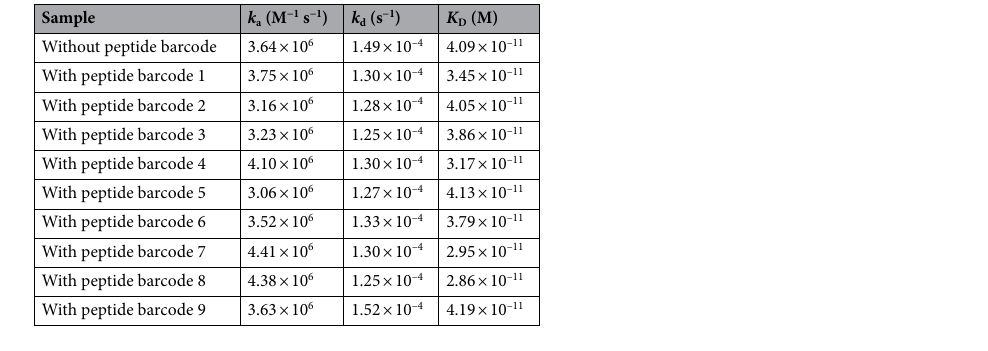
Table 1. Binding kinetics of anti-green fluorescent protein wild-type nanobody fused with peptide barcodes with various physicochemical properties shown in Fig. 2c.